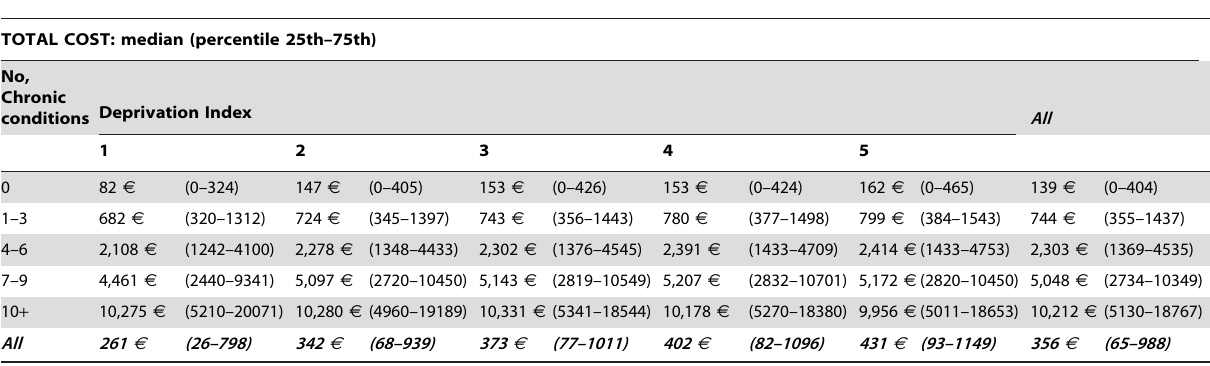
Table 7. Comparison of medians of total health care costs per patient, depending on number of chronic diseases and deprivation index.